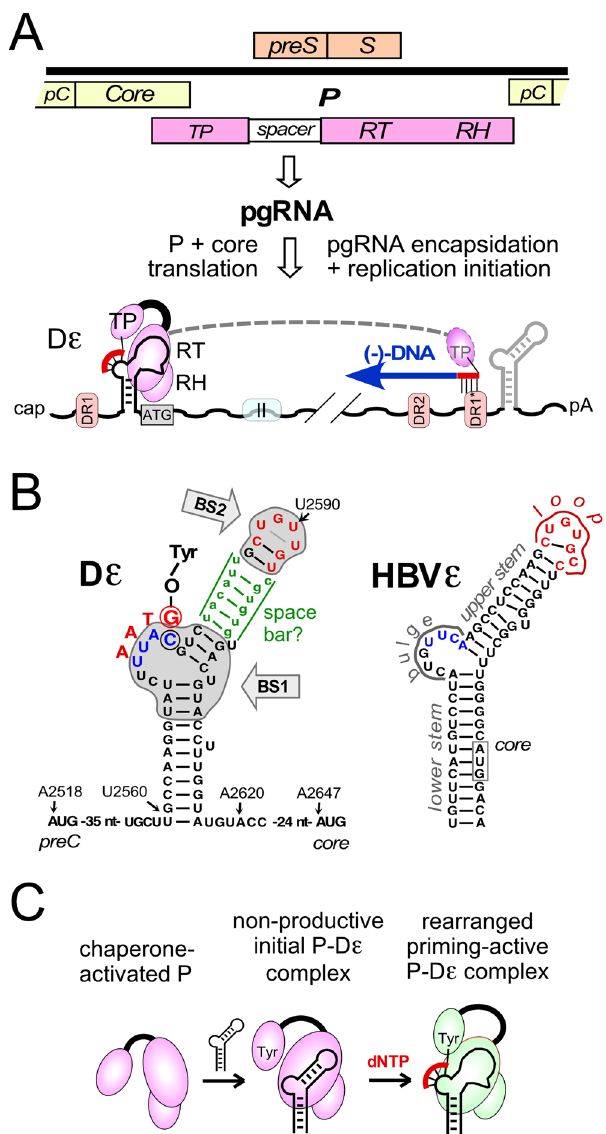
Figure 1. Key roles of the ε RNA stem-loop in hepadnaviral replication. ( A ) Protein-priming and minus- strand DNA synthesis. The 3 kb DHBV DNA genome is schematically shown on the top in linearized form; ORFs for preC (pC), core, preS/S and P with its Terminal Protein (TP), Reverse Transcriptase (RT) and RNase H (RH) domains are indicated. Pregenomic (pg) RNA, transcribed from transfected vector or, in infection, from covalently closed circular (ccc) DNA 43 , serves as mRNA for core and P protein, and as precursor for new RC-DNA. Binding of P protein to 5 ′ ε triggers co-encapsidation of the complex (in DHBV requiring additional downstream sequences symbolized by the box labeled “II” 7, 8 ) into newly forming nucleocapsids (not shown) and synthesis of a short, TP-linked DNA oligonucleotide (“protein priming”); transfer to a sequence-matching acceptor at DR1 * mediates minus-strand DNA synthesis. The subsequent steps towards RC-DNA are not shown. ( B ) Known functional subelements in D ε and comparison to HBV ε . The central bulge and the apical loop are established determinants for ε function. The initiation site is indicated by the encircled C at the 3 ′ end of the bulge, templating a G as first residue linked to TP. The connecting upper stem (green) might act as a space bar ensuring a specific distance between bulge and loop for optimal interaction with the assumed binding sites (BS1, BS2) on P protein 22 . HBV ε exerts a similar structure, except the upper stem structure is more stably basepaired. A general assignment for the ε subelements lower and upper stem, bulge and loop is given on the HBV ε structure. The apical sequences in D ε and ε given in red denote the classical heptaloop (DHBV) and hexaloop (HBV), the intra-loop pairings shown are derived by NMR. ( C ) Distinct steps during protein-priming deduced from in vitro priming systems available for DHBV but not HBV. P protein activation by chaperones (dispensable for miniDP used here) enables initial binding to D ε ; mutations in D ε can cause an arrest at this stage. Rearrangements in RNA and protein provide the complex with priming activity (green protein color), enabling synthesis of the bulge-templated DNA oligo